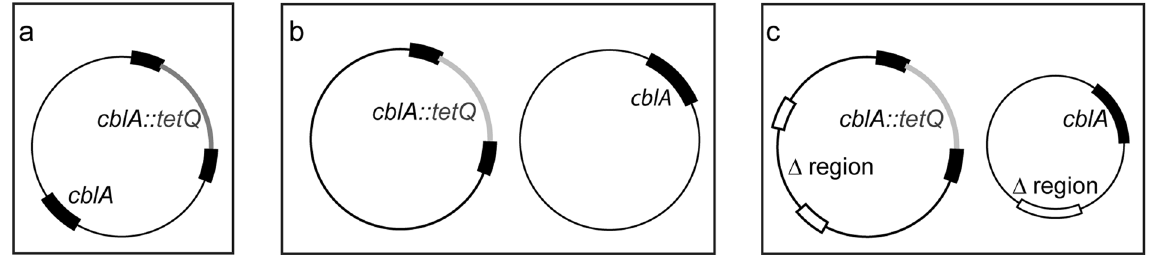
Figure 2. Schematic representation of 3 possible cblA gene duplication scenarios: ( a ) insertion of duplicated cblA gene into random position of chromosome, ( b ) diploid bacteria carrying 2 identical chromosomes differing only in their respective cblA allele, ( c ) partially diploid bacteria due to partial deletion from the 2 nd chromosome with the chromosomes differing in their respective cblA allele, the gene content and synteny.